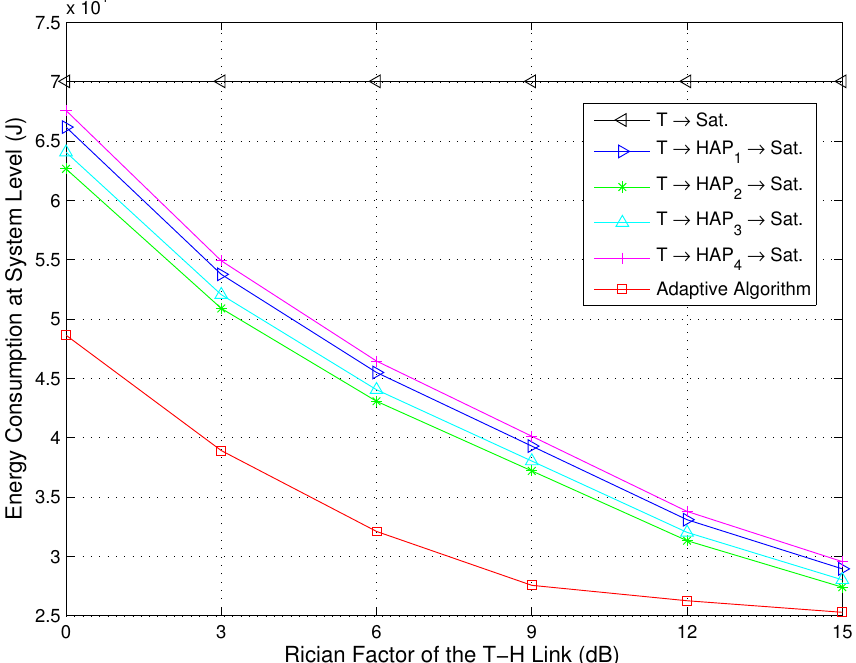
= 100 , κ = 12 dB). T 1